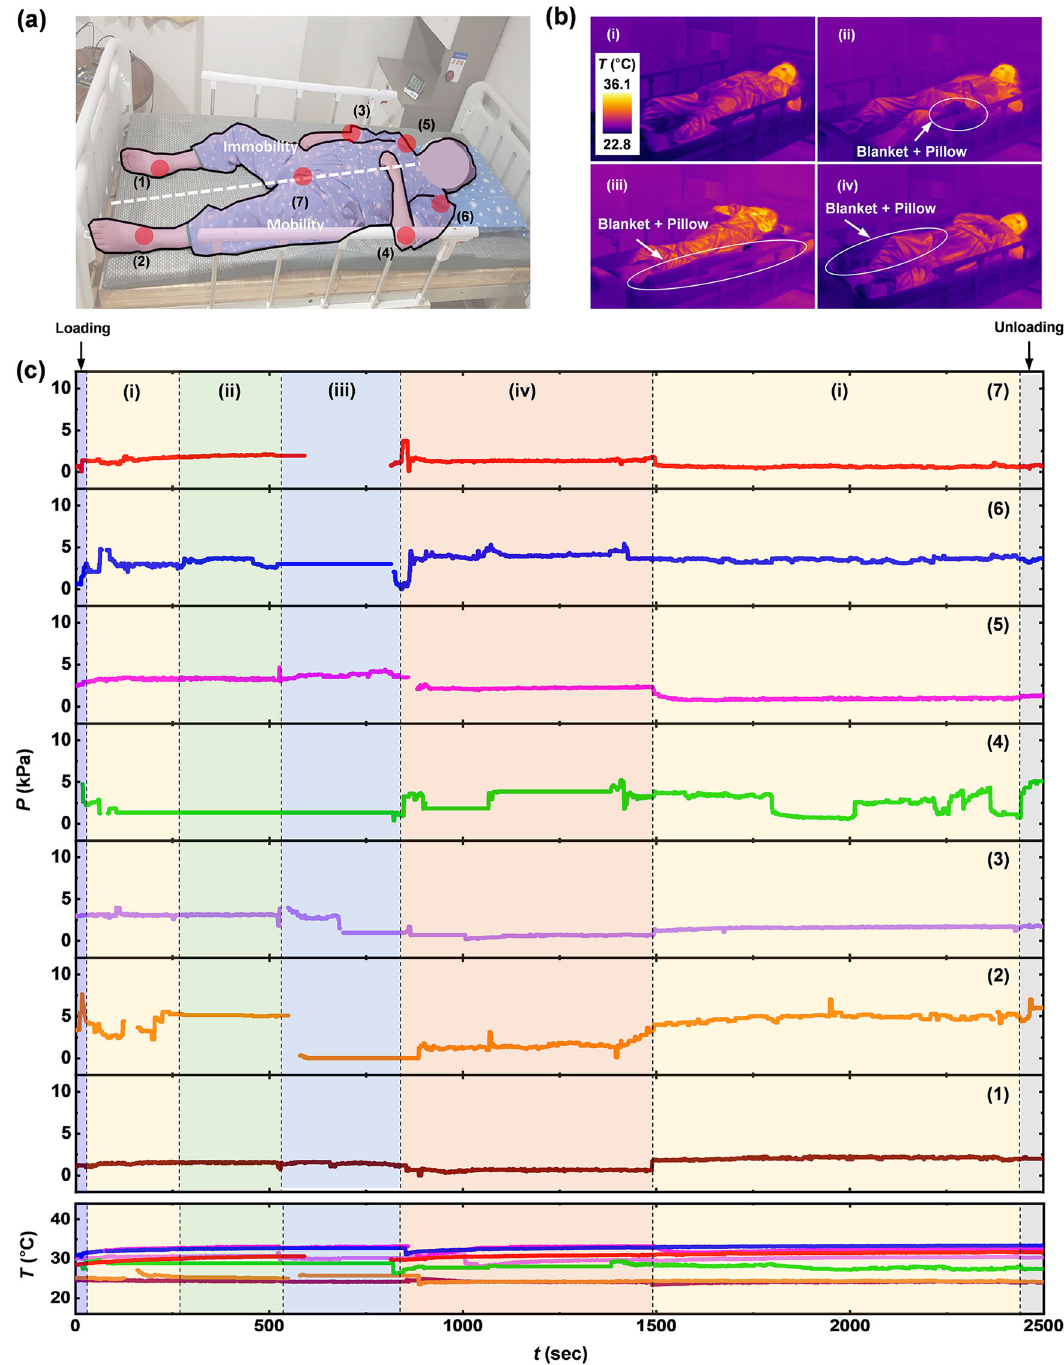
Fig. 7 Continuous measurements of pressure and temperature from a subject with right hemiplegia (47-year-old female, 62 kg, 160 cm) using the wireless-sensing platform. a Photograph of the subject with red discs to mark the mounting locations of the sensors. b IR images of changes in posture of the subject lying on bed with a pillow at different positions. c Results from continuous measurements of pressure and temperature from each of the